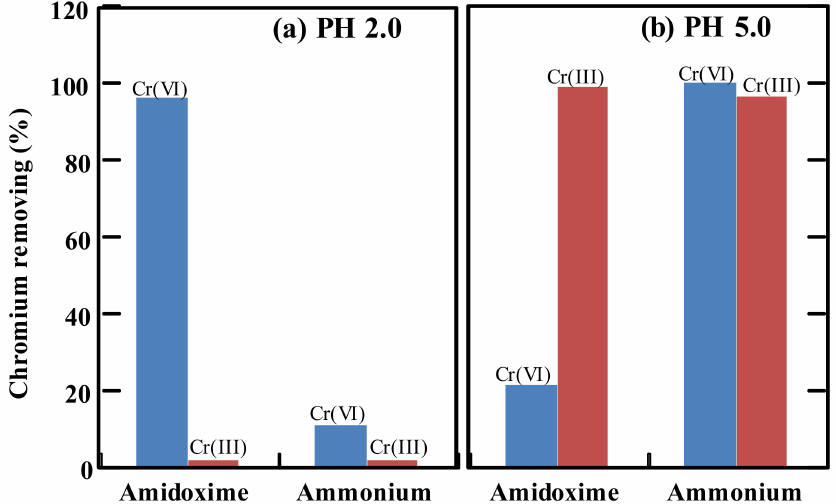
Figure 6. Chromium removing by amidoxime and ammonium adsorbents in the batch mode adsorption at ( a ) pH 2.0 and ( b ) pH 5.0. Initial chromium solution, 0.1 ppm; volume, 45 mL; density of functional groups, 4.53 mmol/g for the amidoxime adsorbent and 3.51 mmol/g for the ammonium adsorbent; adsorption time, 90 min; room